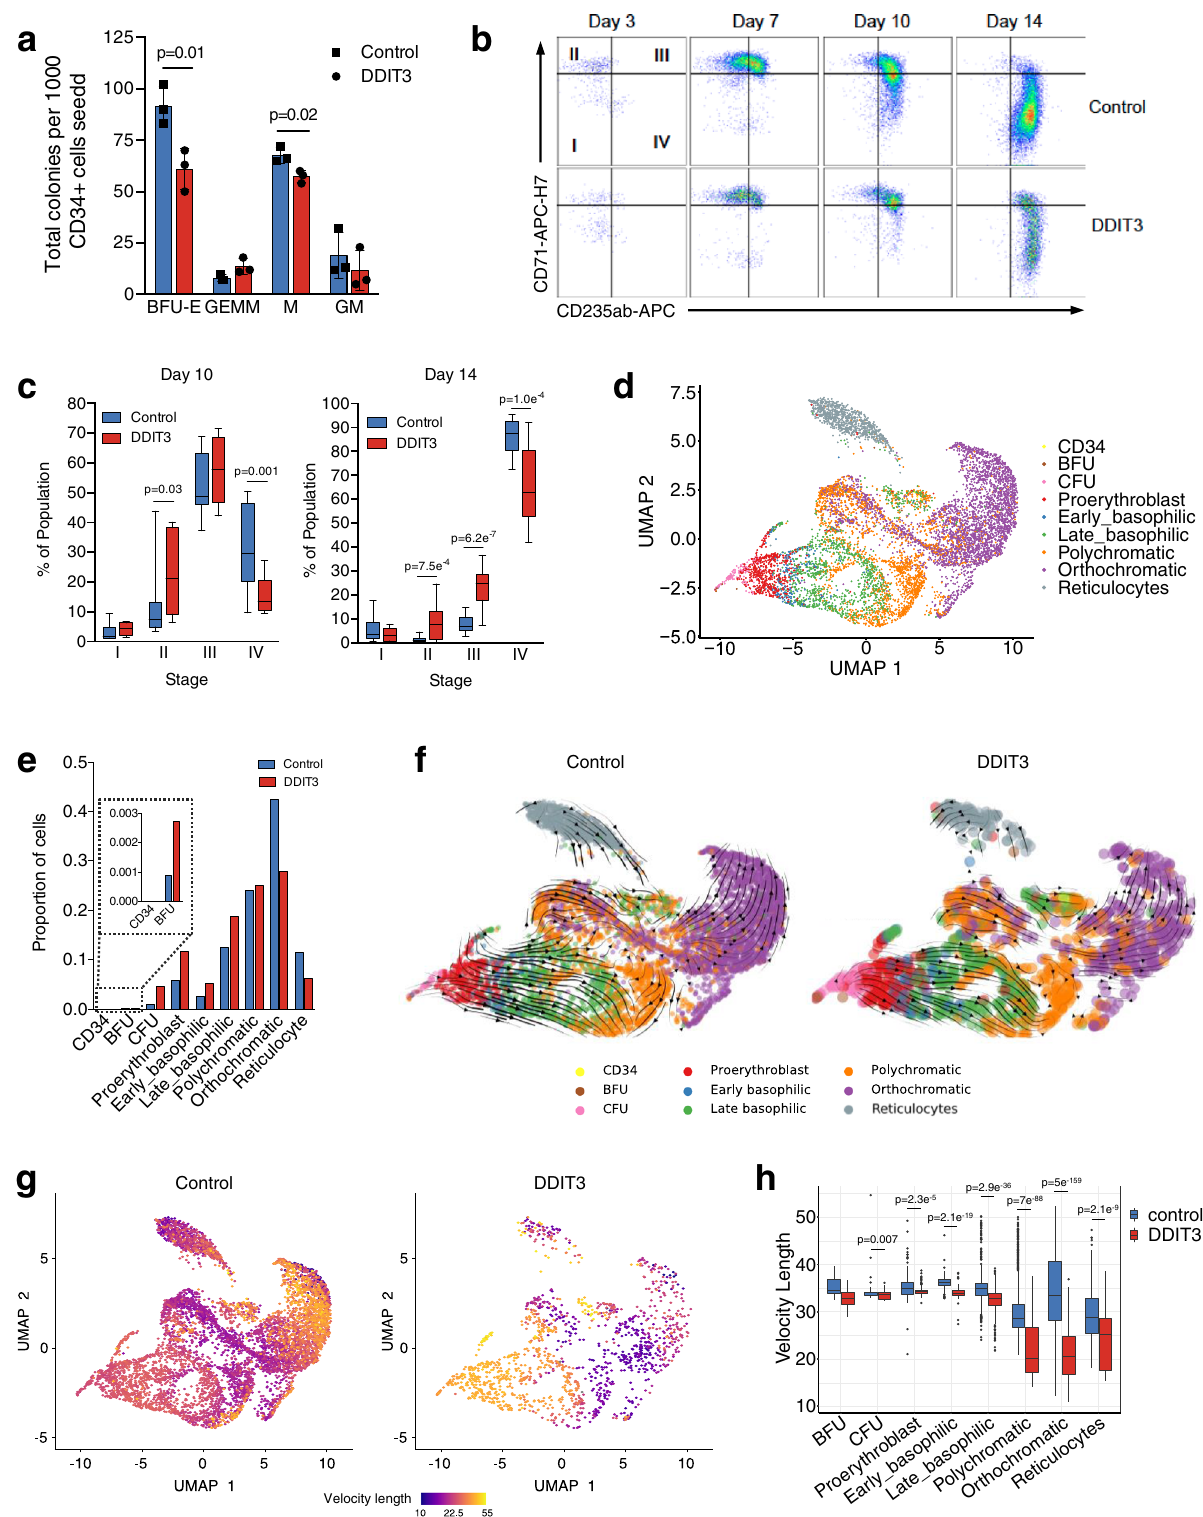
(Fig. 5e, details for KLF1 , ARID4B and SOX6 in Fig. 5f),